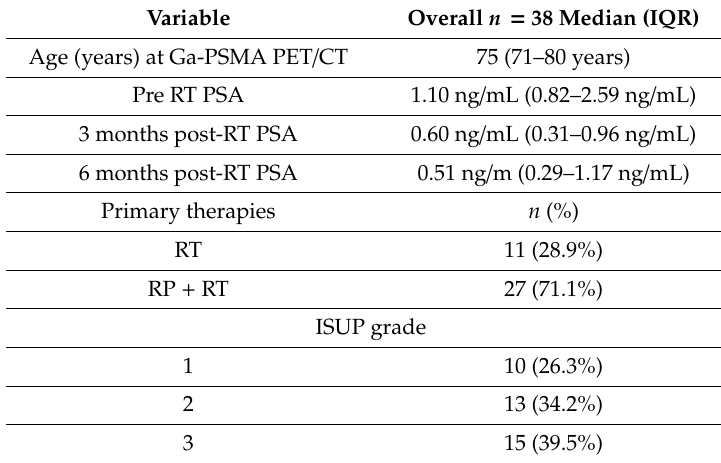
Table 1. Patients